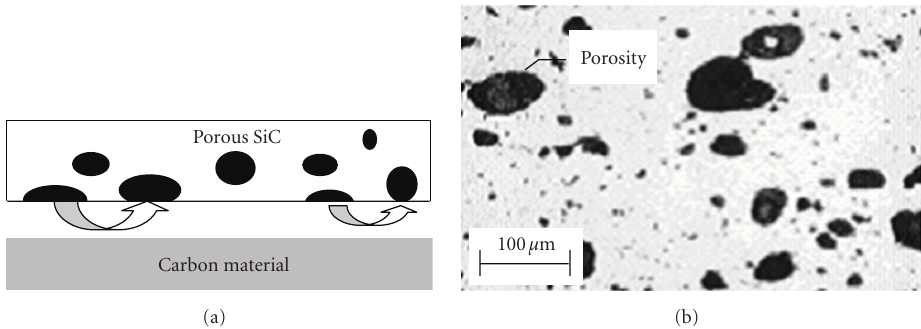
Figure 5: (a) Drainage of the lubricant from a cavity to another one. (b) micrograph of the porous silicon carbide.